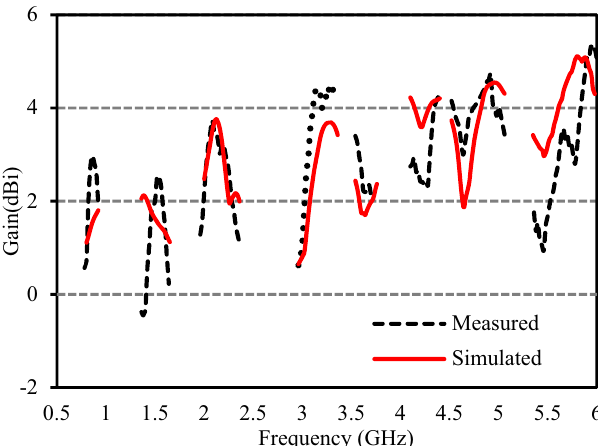
Figure 11. Measured and simulated peak gain.